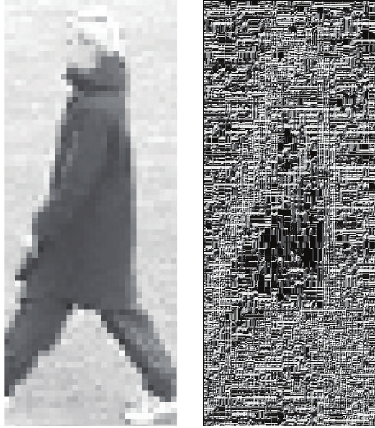
Figure 2: Calculating LBP of a person. Figure 3: Calculating HOG of a